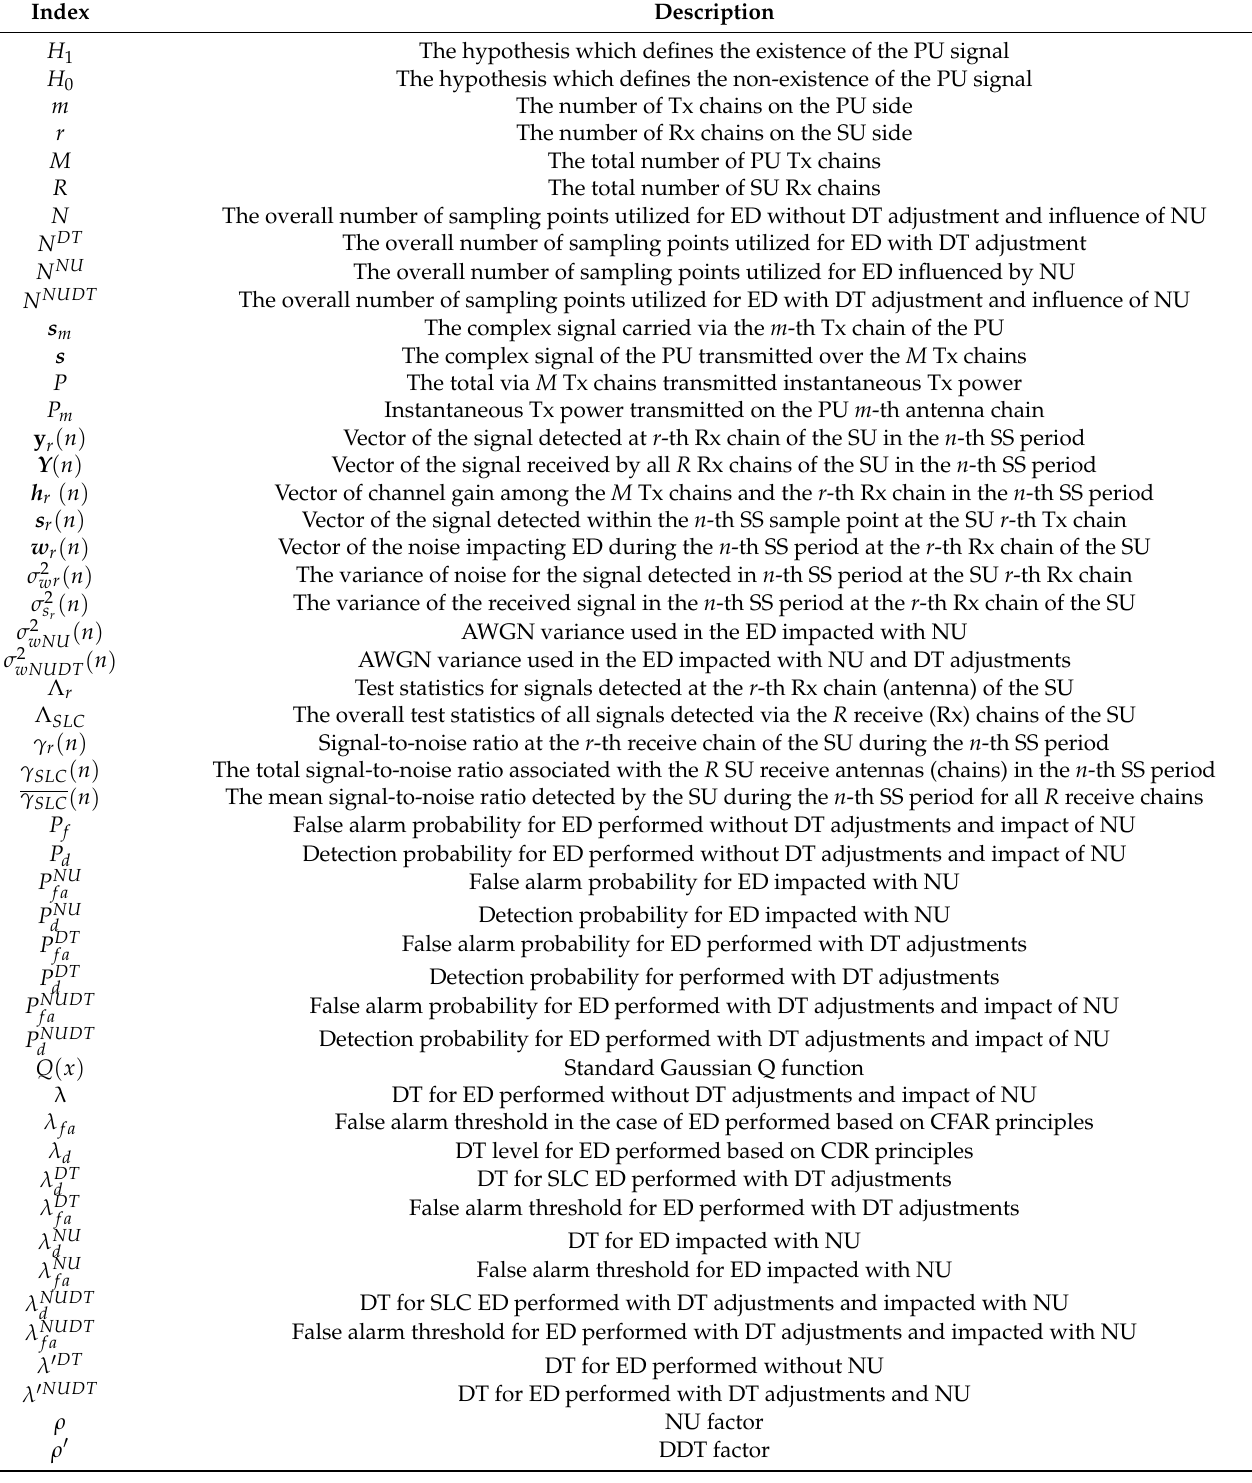
Table 2. Parameters used in the simulation